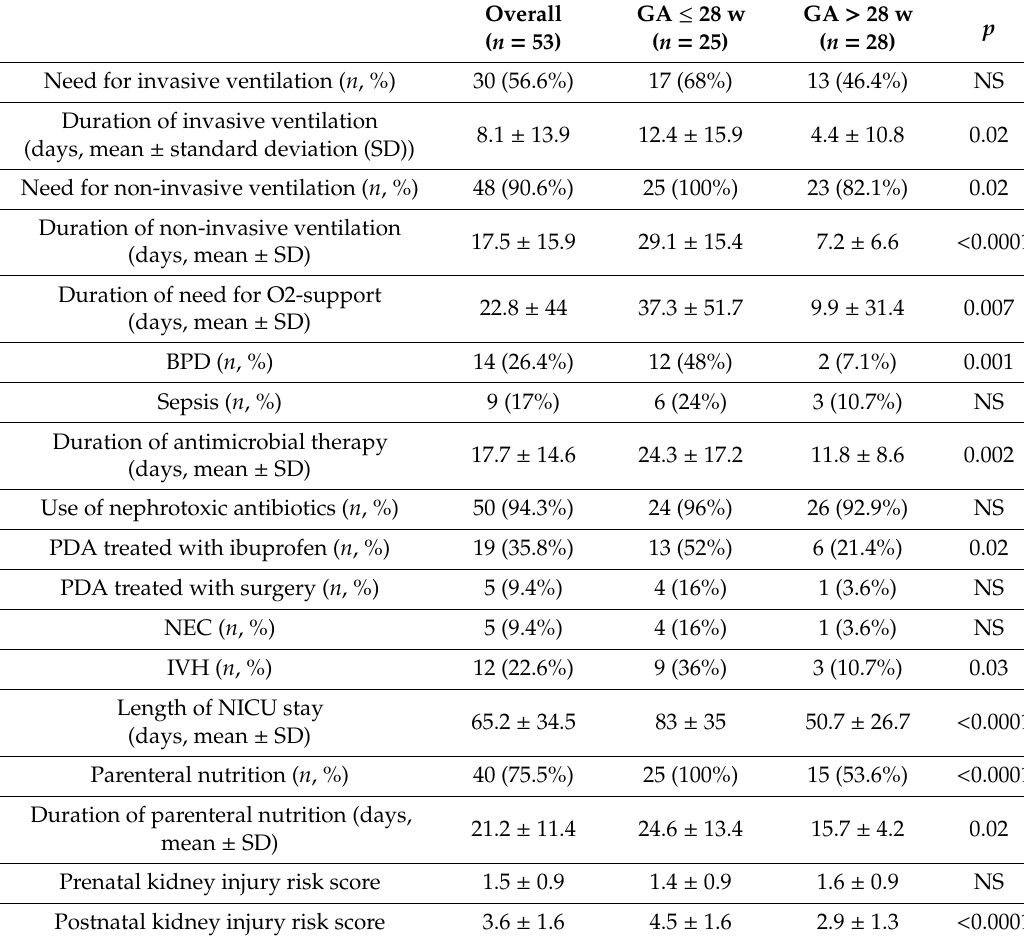
Overall GA ≤ 28 w GA > 28 w p ( n = 53) ( n = 25) ( n = 28) 8.1 ± 13.9